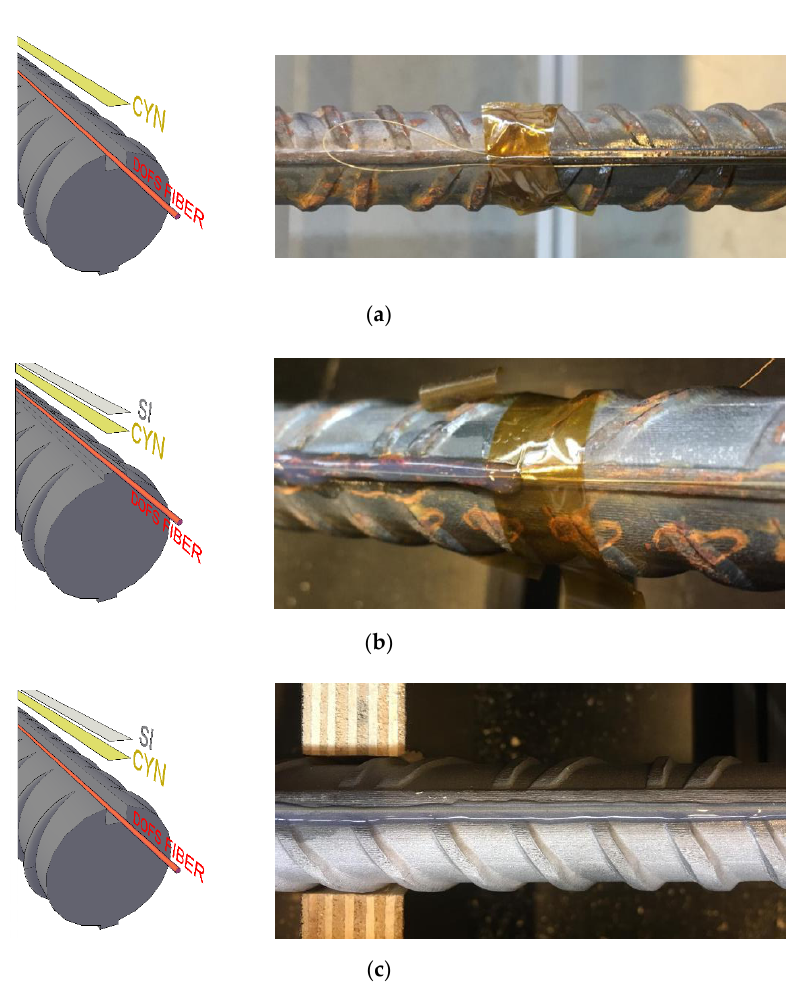
Figure 5. Graphical and photographical representation of the three tested bonding techniques ( a ) positioning of DOFS in an incised groove and bonding it with CYN ( b ) bonding it with CYN with an additional protective layer of SI ( c ) positioning of the DOFS in a groove, bonding through CYN and protection through SI.